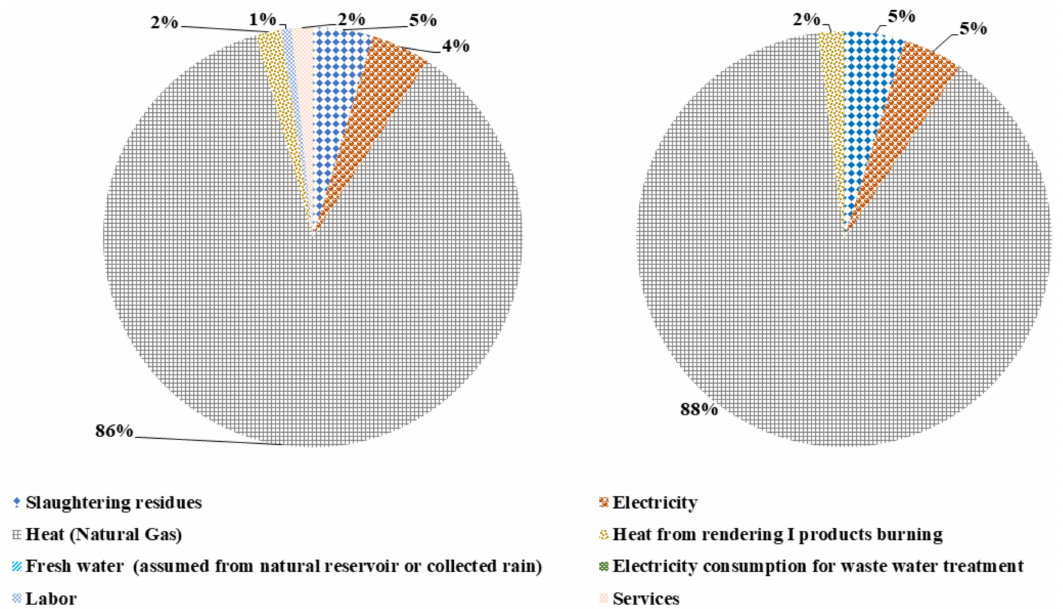
Figure 3. Emergy content share contribution of different input flows for rendering II with and without